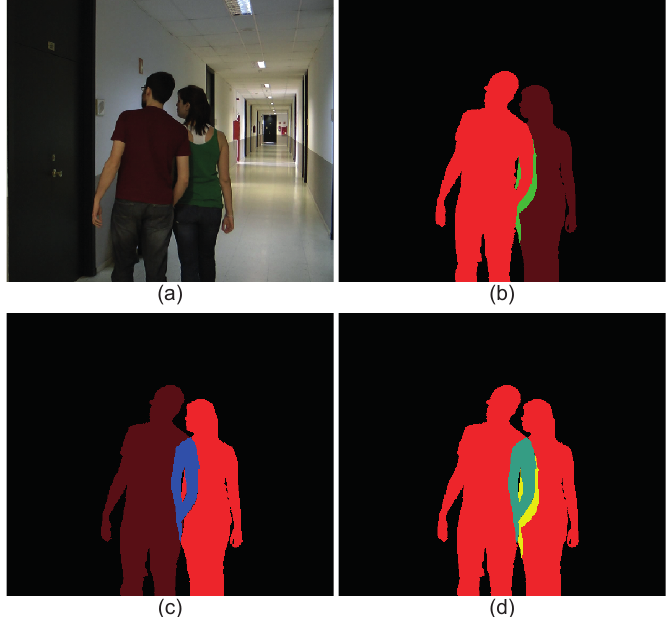
Figure 3. Layers obtained from an image with two moving objects partially occluded. ( a ) Original image; ( b ) layers of the left object (VMO in red and SMO in green); ( c ) layers of the right object (VMO in red and OMO in blue); ( d ) layers of both objects (VMO in red, SMO in yellow and OMO in